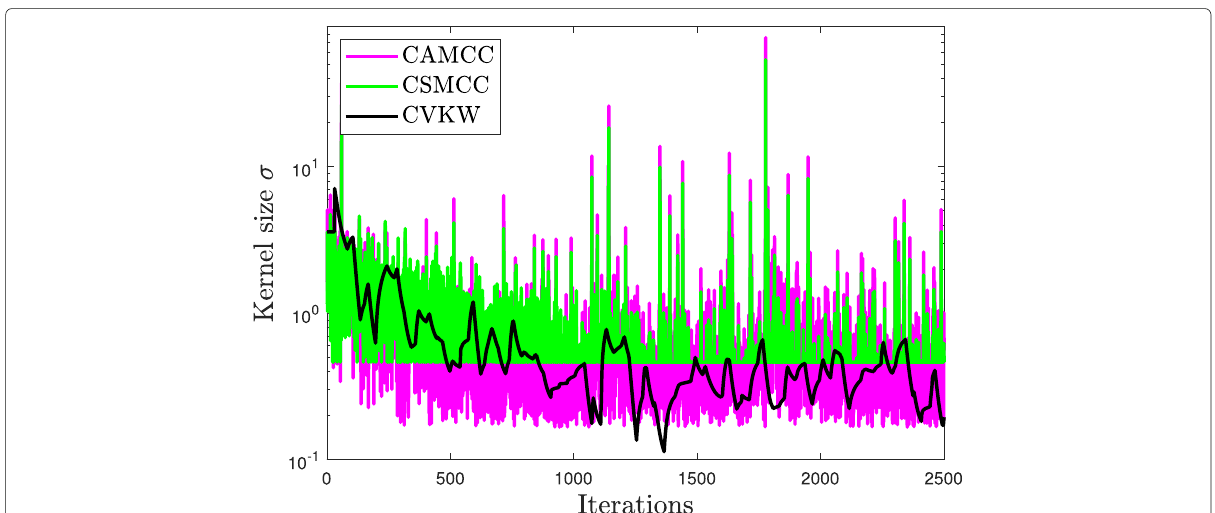
Fig. 3 Typical evolution of the Kernel size σ used by AMCCC, SMCCC, and CVKW in the scenario of Fig. 2